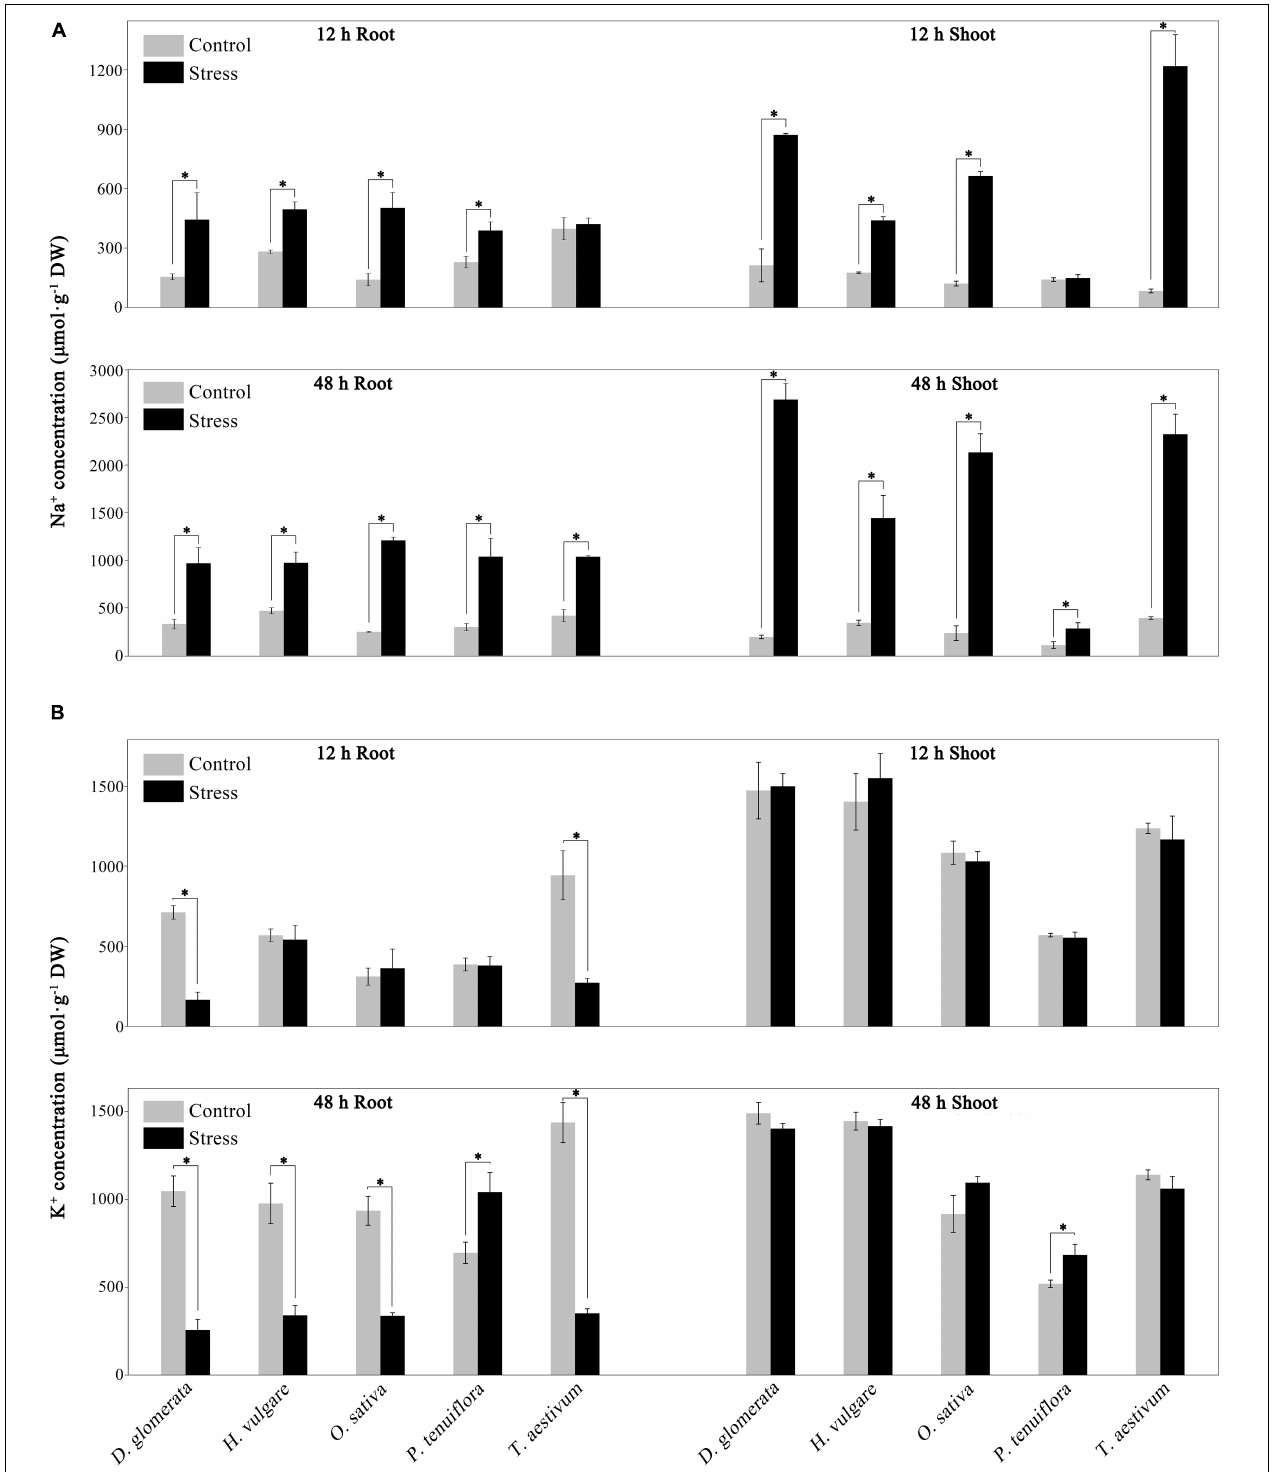
FIGURE 5 | Effects of salinity stress on Na + (A) and K + (B) concentration in P. tenuiflora , O. sativa , H. vulgare , D. glomerata, and T. aestivum . The 15-day-old seedlings were exposed to 300 mM NaCl for 12 and 48 h. Values are expressed as means ( ± standard deviation, S.D.) of the three biological replicates. ∗ Indicates a significant difference between control and stress conditions within the same tissue at the 0.05 level, according to the t -test.